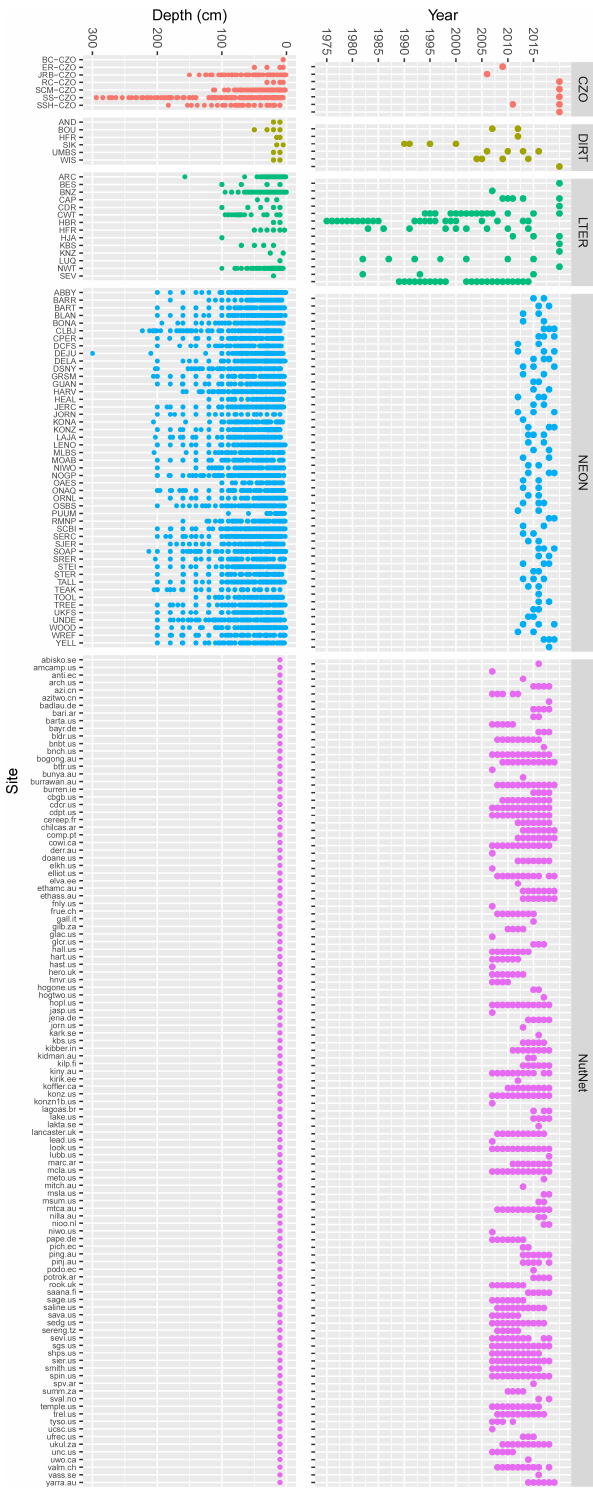
Figure 5. Temporal coverage and depth of measurements taken from different study sites and grouped by research network. Our intent with this figure is to illustrate the number of sites in each network, the temporal length of their data record, and the depth to which soils are typically